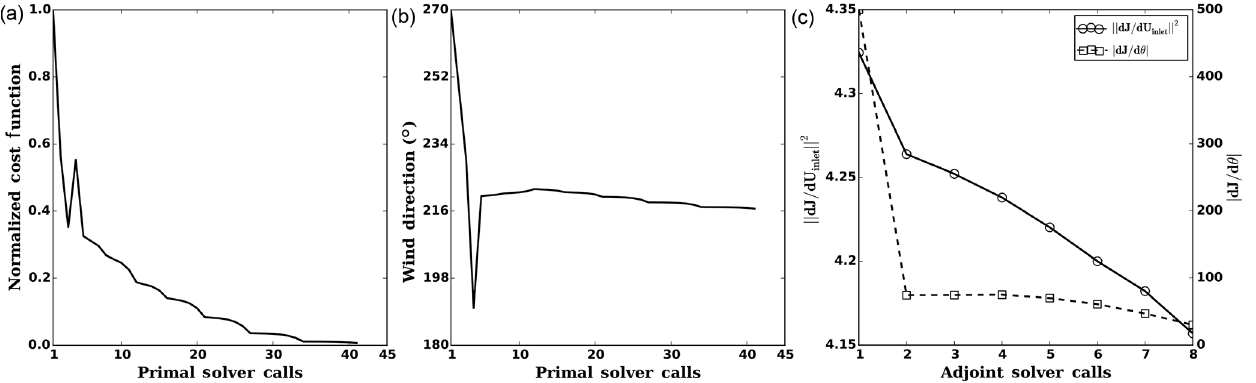
Figure 10. Inflow boundary calibration for the Kassel domain; cost function convergence (a) , wind direction history (b) and gradients history (c) .